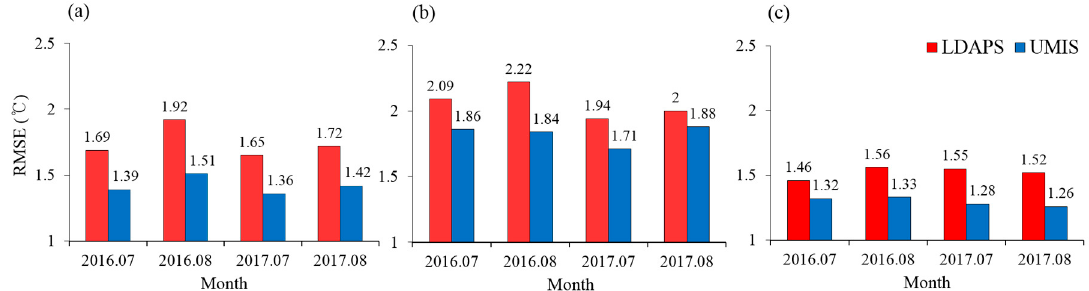
Figure 14. Assessment of the downscaled temperature from post-processing. ( a ) All hourly temperatures; ( b ) daily maximum temperature; ( c ) daily minimum temperature. LDAPS, Local Data Assimilation and Prediction System; UMIS, Urban Meteorological Information System.